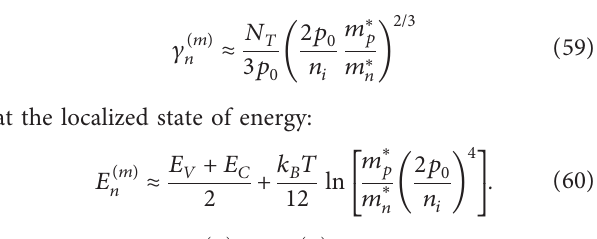
and τ n are varying oppo- 0 0 , τ , τ , and τ ne pe pt nt